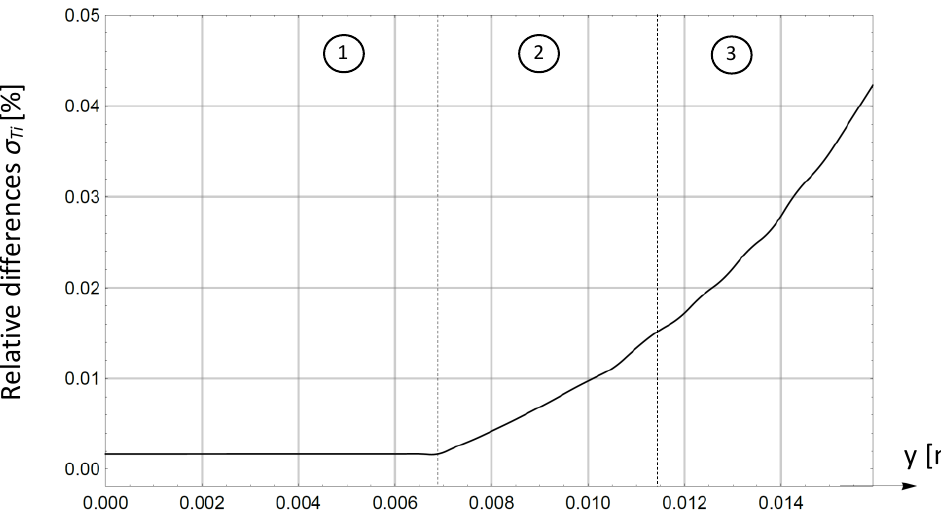
Figure 8. The relative differences (34) on the minor semi-axis ( x = 0).